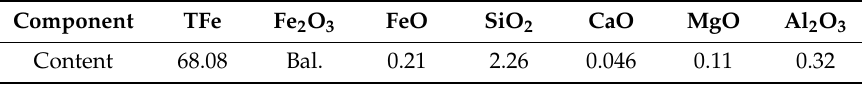
Table 1. Compositions of the Brazilian iron ore